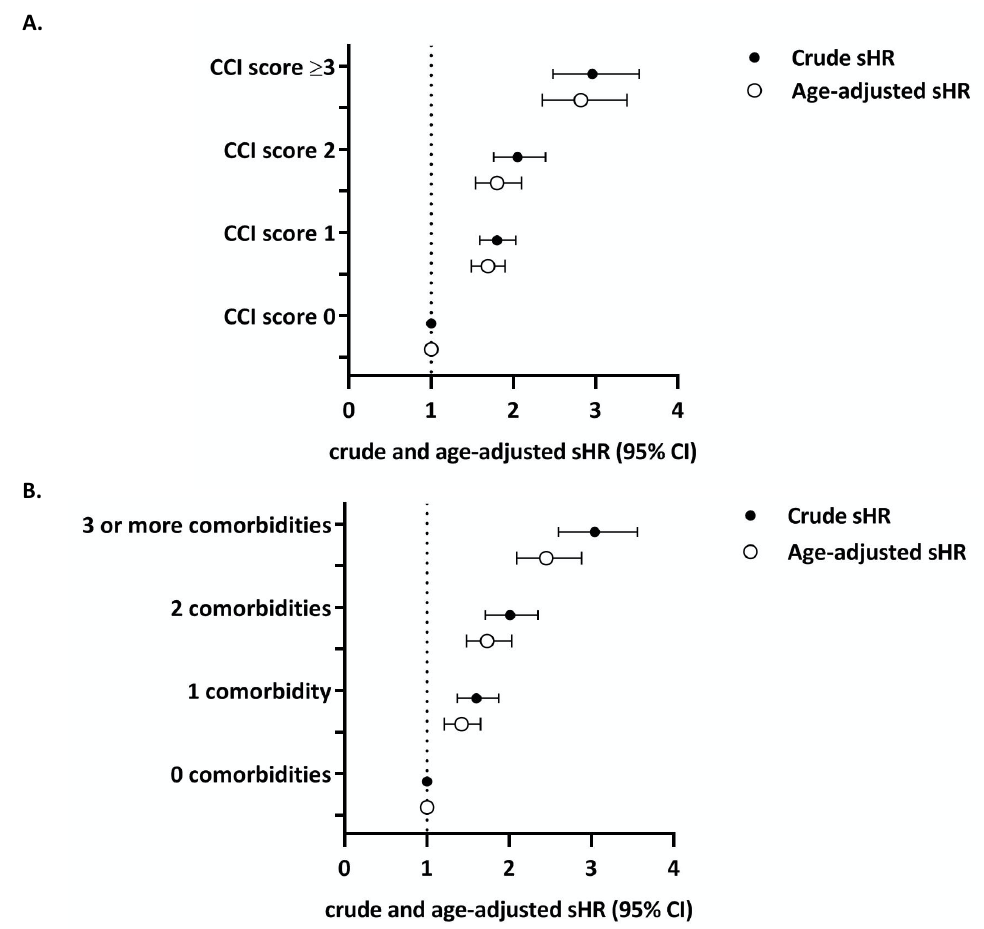
Figure 3. ( A ) Crude ( ● ) and age-adjusted ( ○ ) subdistribution hazard ratios (sHRs) for 5-year other-cause mortality by Charlson index. ( B ) Crude ( ● ) and age-adjusted ( ○ ) sHRs for 5-year other-cause mortality by comorbidity count.